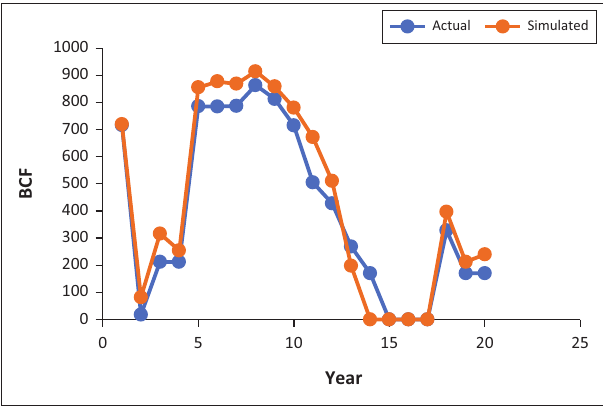
FIGURE 6: Comparing the simulation results versus the actual results for the quantity of gas available for export.